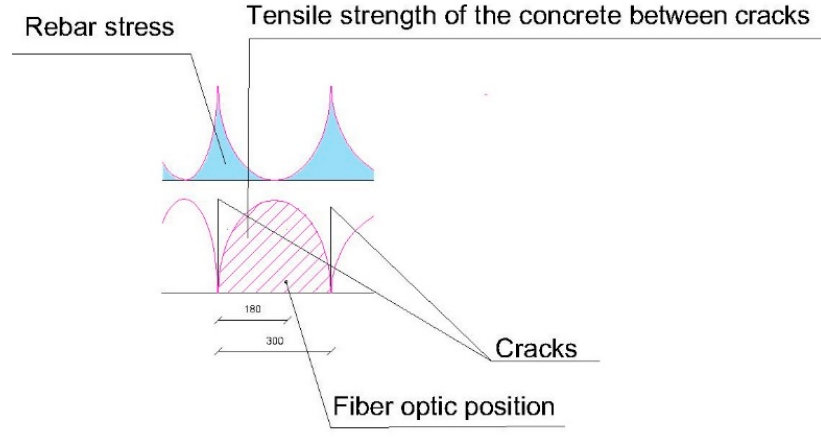
Figure 16. Determining deformation of the steel between cracks on 200 × 300 mm beam.